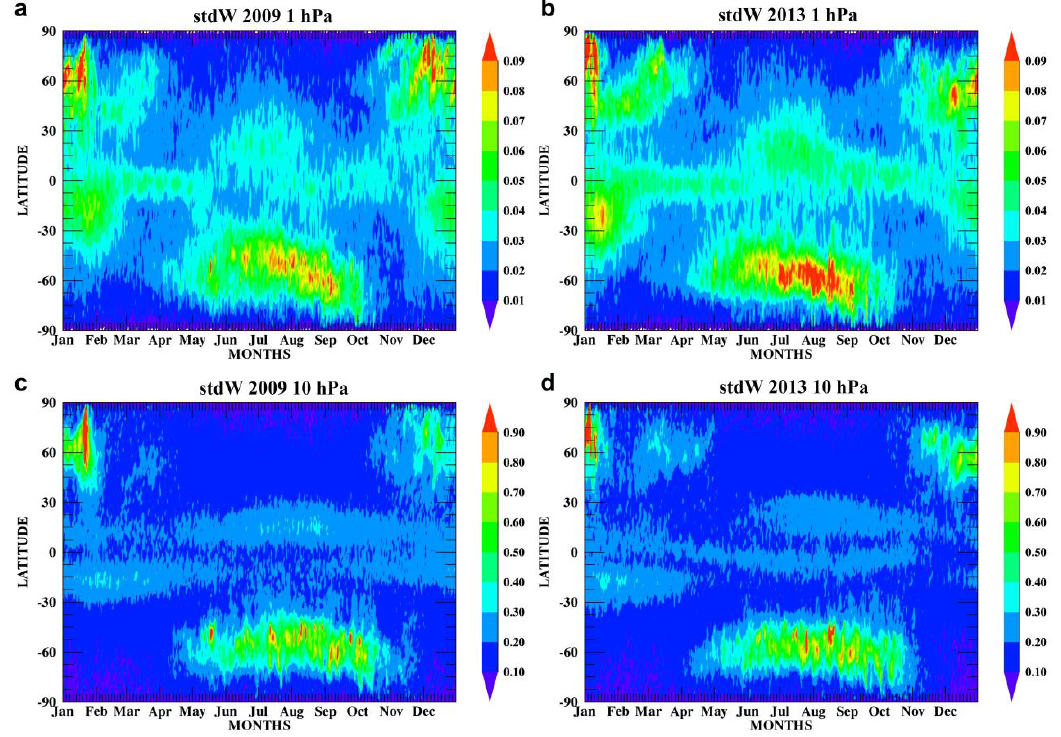
Figure 4. Latitude-temporal variations in the stdW at 1 hPa ( a, b ) and 10 hPa ( c, d ) in 2009 ( a, c ) and in 2013 ( b, d ). Latitudes are on the vertical scale, months of year are on the horizontal one.